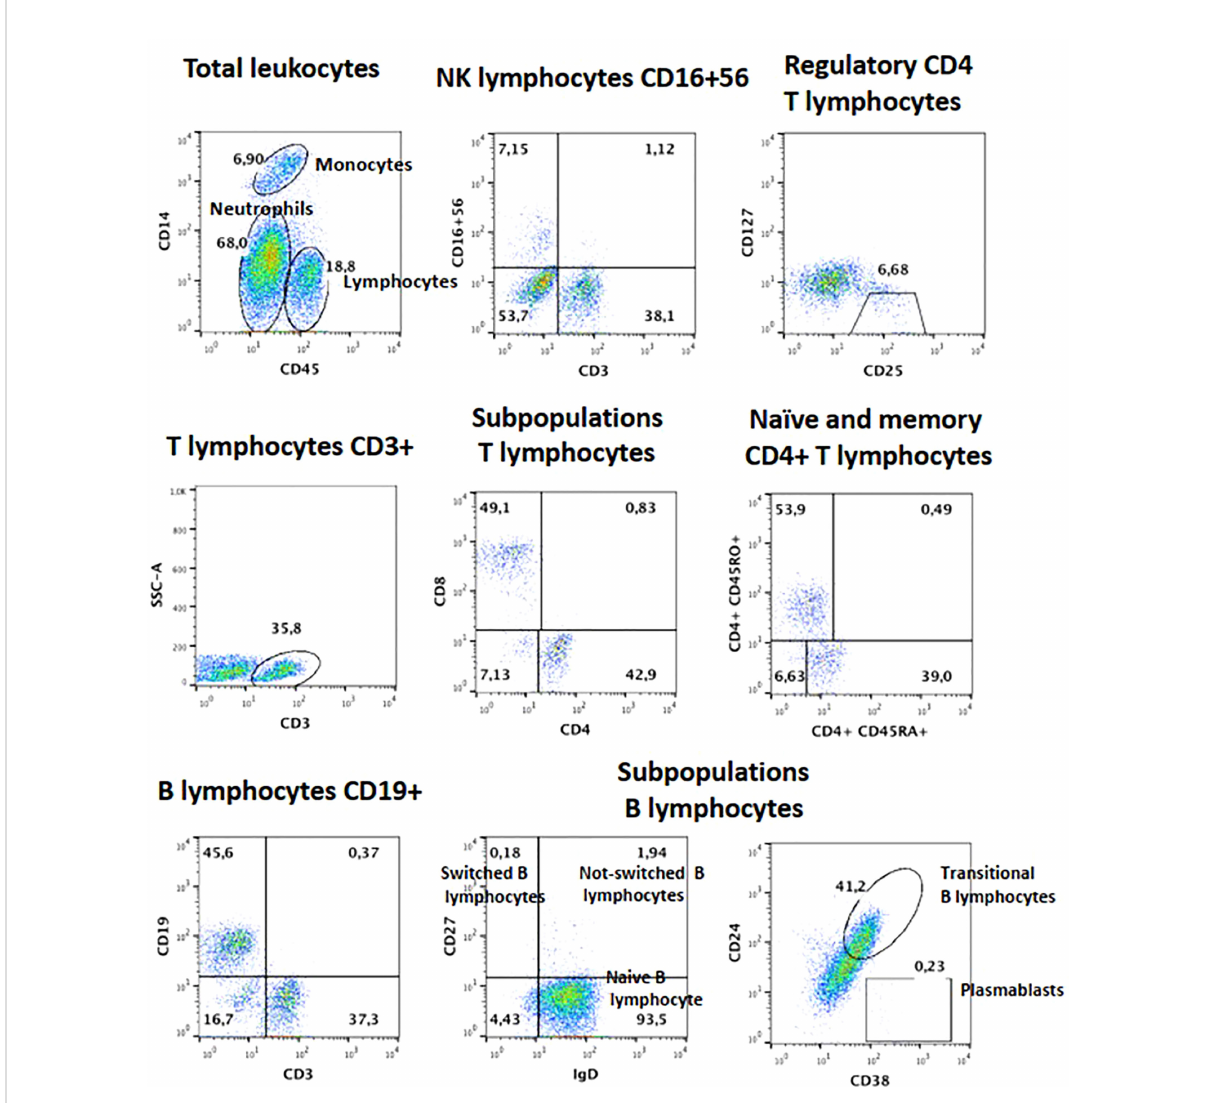
FIGURE 5 Lymphocyte subsets for B and Treg cells from patient 1, after failed HSCT with mixed chimerism. Plasmablasts and Memory B cells are low, as are